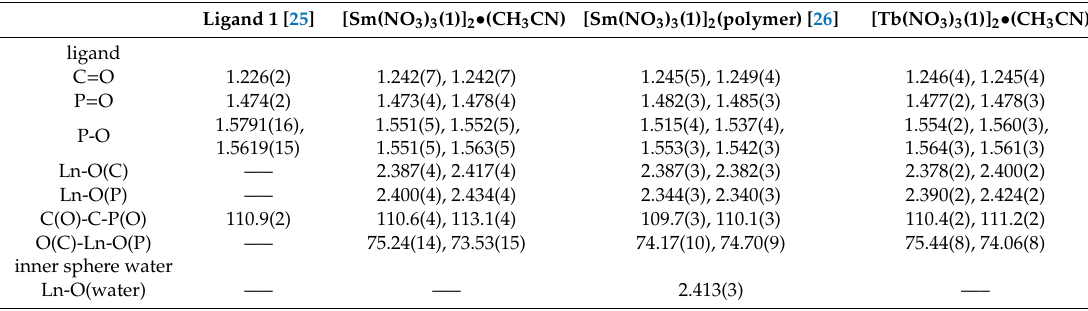
Table 3. Selected bond distances (Å) and angles ( ◦ ) for ligand 1 [25] and its Sm(NO 3 ) 3 (dimeric),